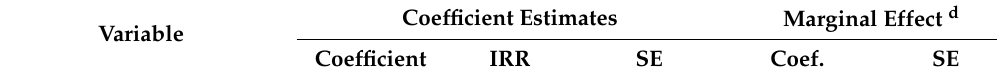
Table 9. Estimated coefficients and marginal effects of the zero truncated Poisson regression